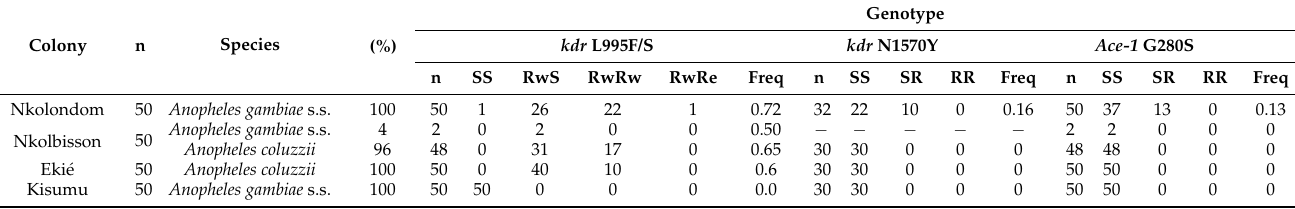
Table 1. Frequencies of kdr L995F/S and N1570Y and Ace-1 G280S resistance alleles among Anopheles gambiae s.s. and